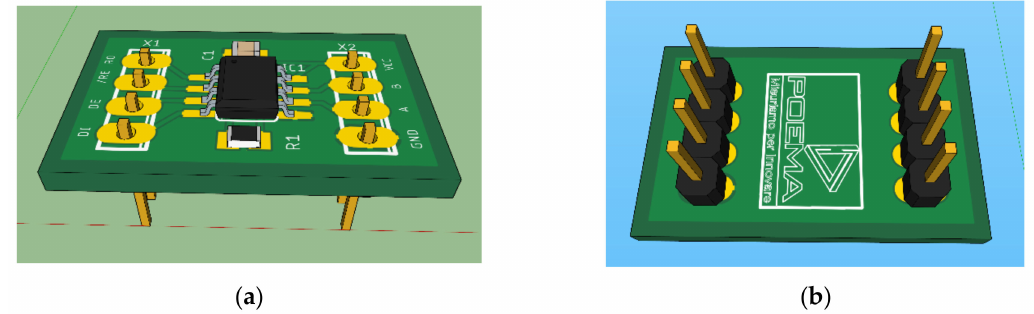
Figure 6. A 3D view of the RS485 module: ( a ) front side; ( b ) back side.